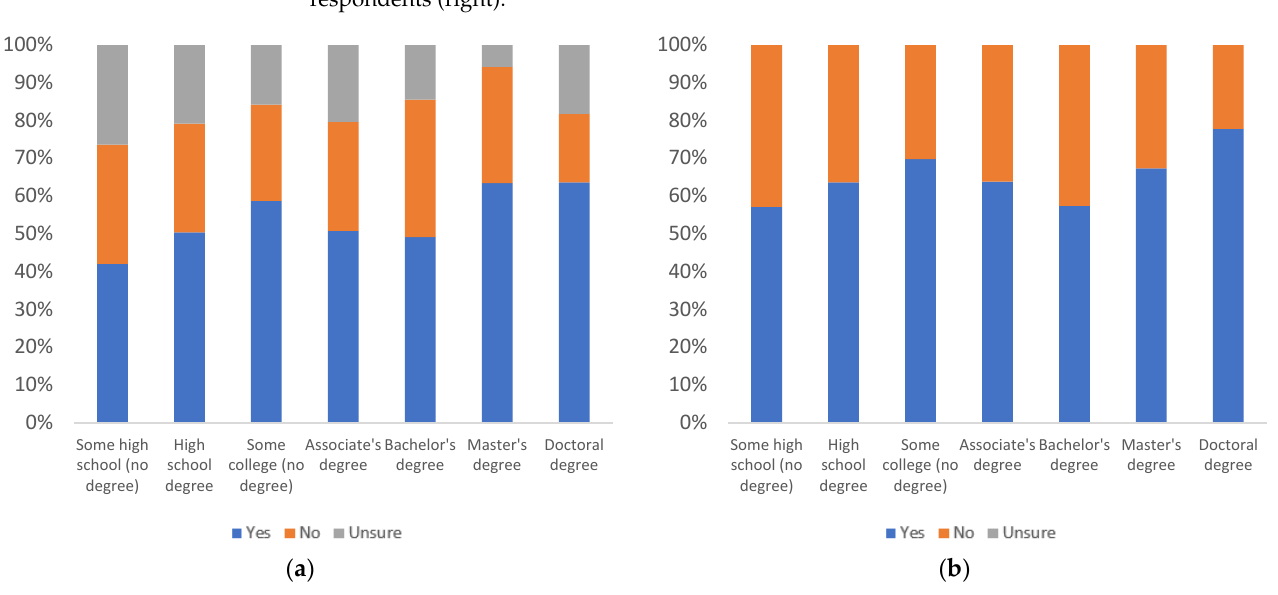
Figure 12. Label use, by education level: ( a ) with uncertain respondents (left) and ( b ) without un- certain respondents (right).